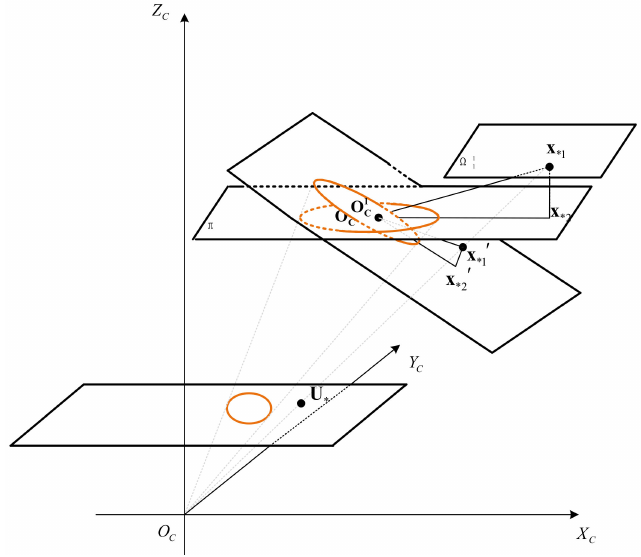
Figure 2. This is a figure of the spatial relationship of a point and circle corresponding to the